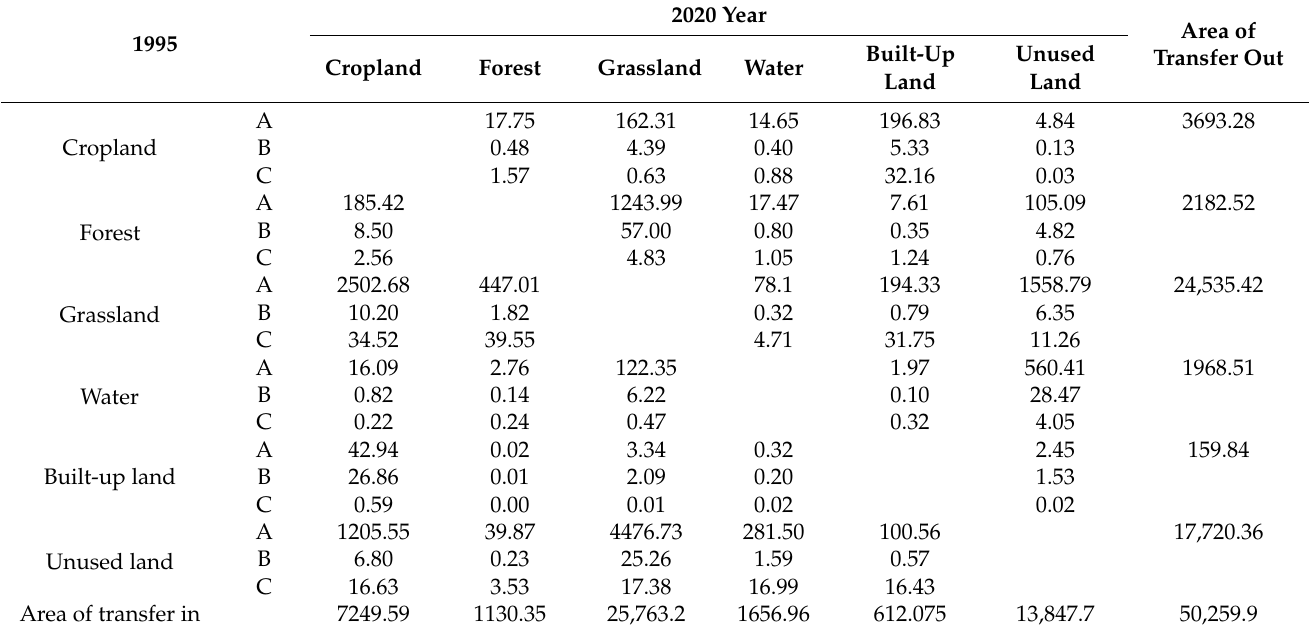
Table 4. Land-use transfer area and proportion in the Ebinur Lake Basin during